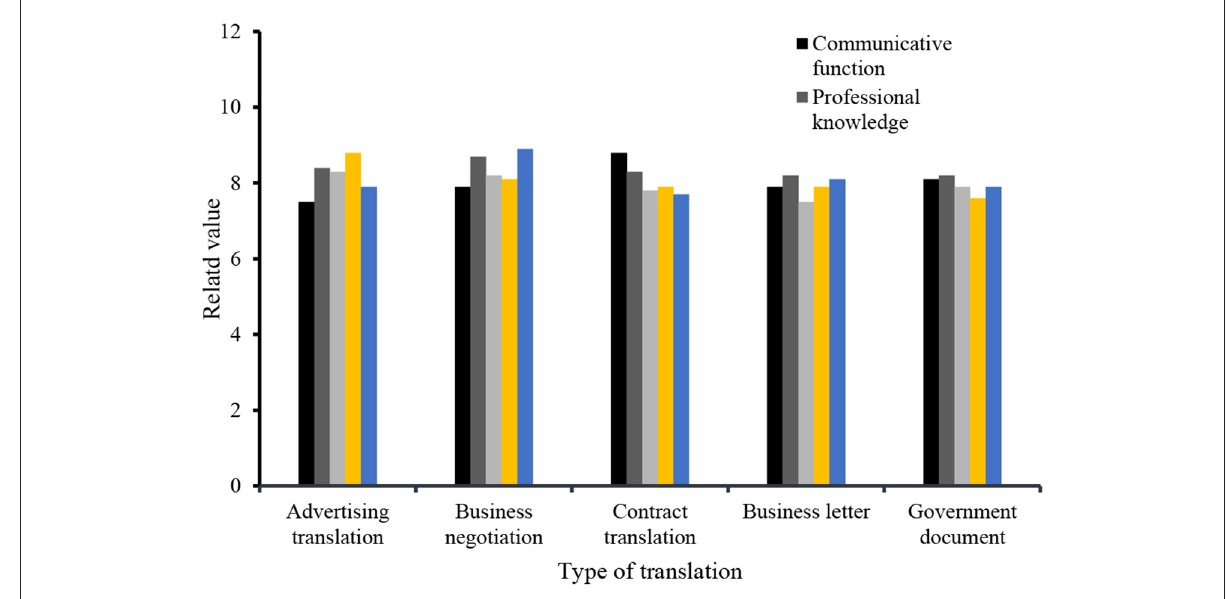
FIGURE4 The specific content of business English translation.